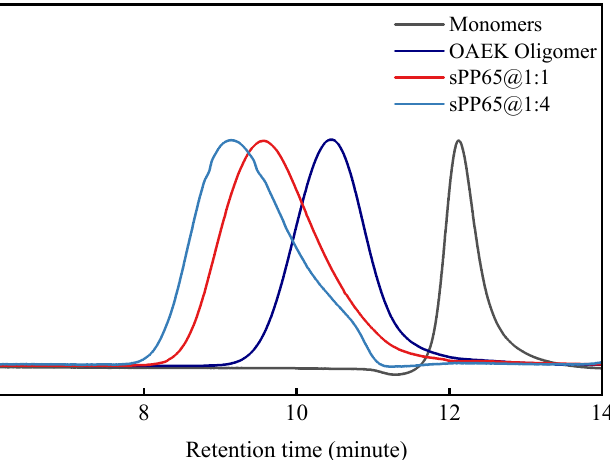
Figure 3. GPC profiles of the starting materials and sPP65@1:1 and sPP65@1:4 block copolymers catalyzed by NiBr 2 (PPh 3 ) 2 equivalents using different molar ratios of p NDCBS and m NDCBS; related properties are listed in Table 1.